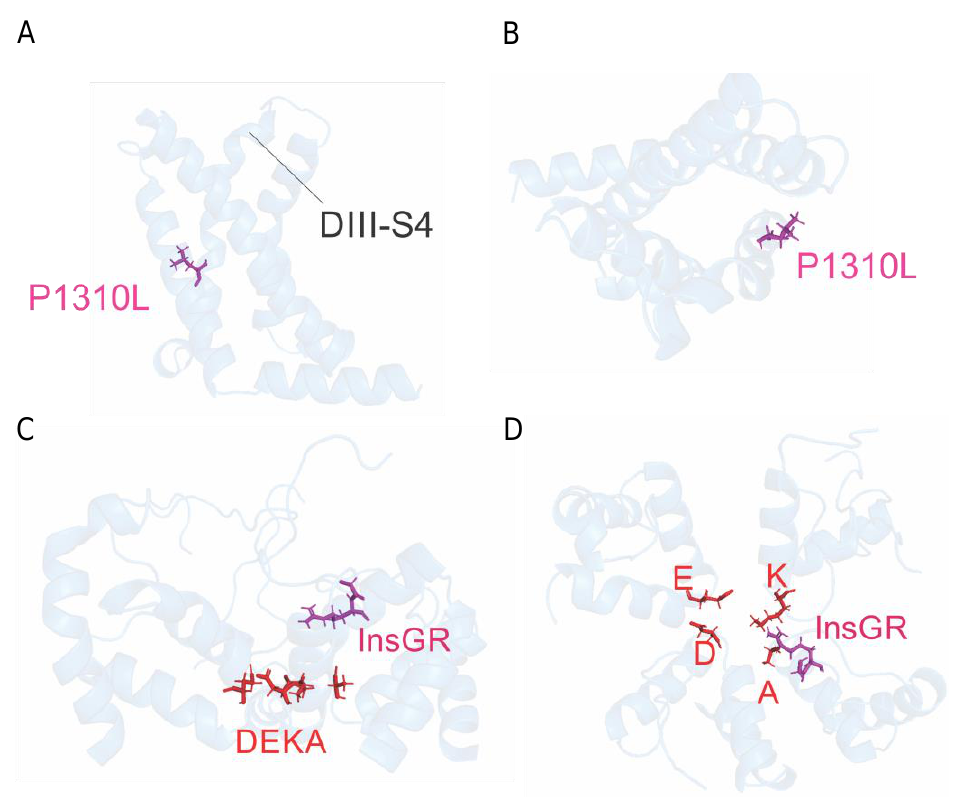
Figure 2. Localization of the BrS mutations in the Nav1.5 channel modeled on the 3D structure of the rat Nav1.5 α -subunit (pdb: 6UZ3). Lateral ( A ) and top ( B ) view of Nav1.5 channel showing the P1310L mutation depicted in purple. Lateral ( C ) and top ( D ) view of the Nav1.5 channel showing the Ins1687GR insertion in purple. The DEKA residues are shown in red.